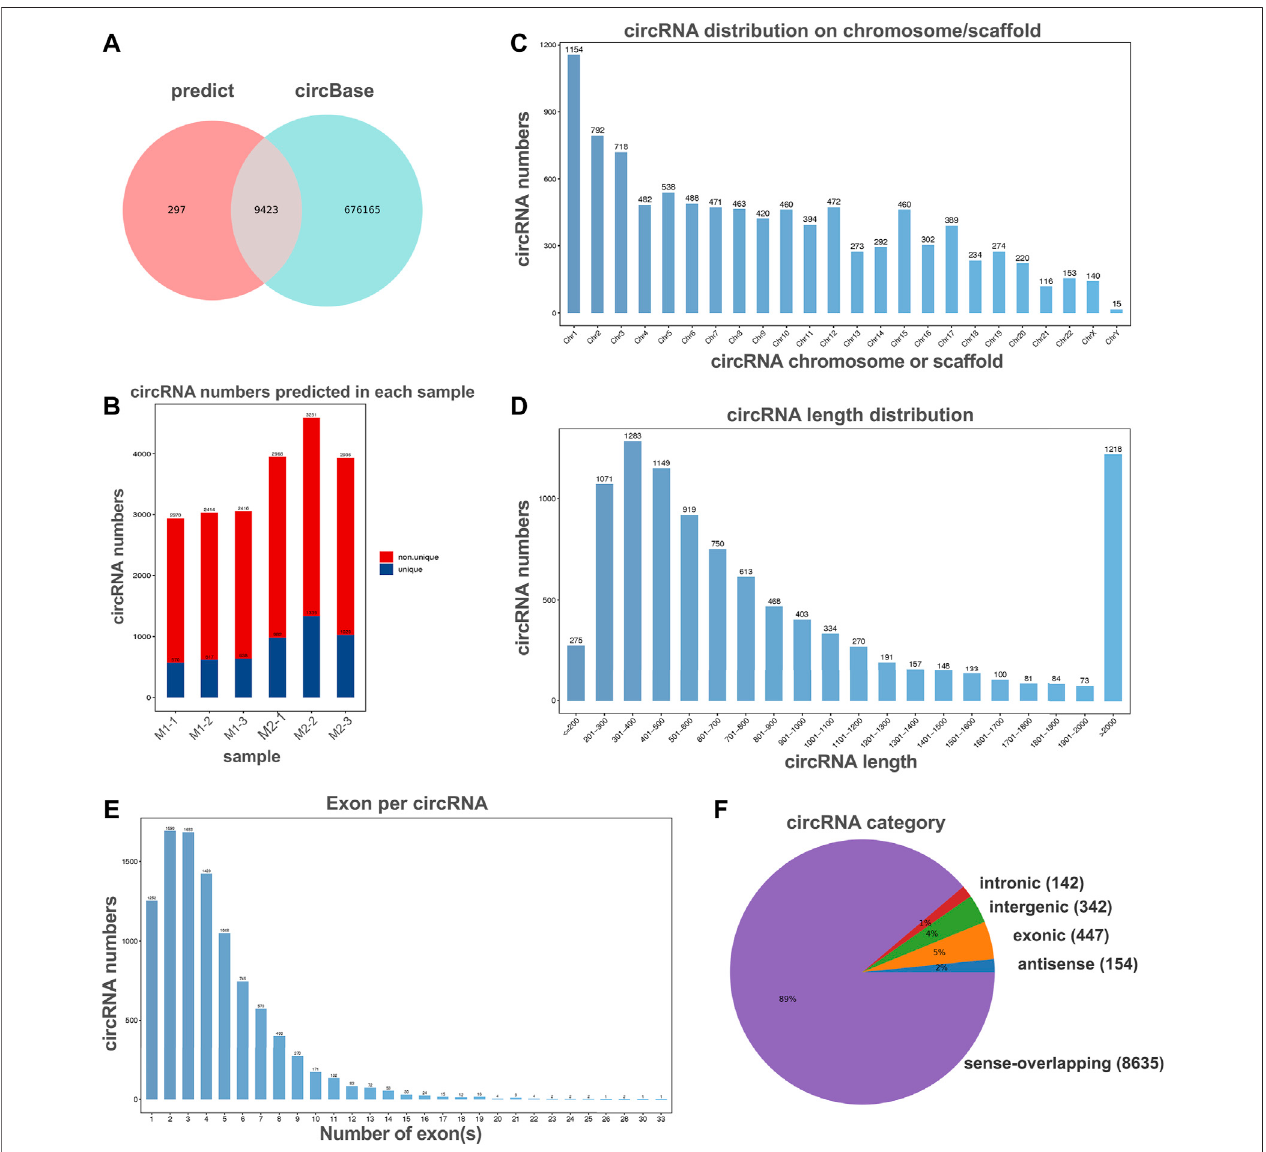
FIGURE2| Overview ofcircRNA pro fi les ofpolaroized macrophages. (A) Venn analysisfor comparison ofpredictedcircRNAs withthedata published in circBase. (B) The number of predicted circRNAs in M1 macrophages (M1-1, M1-2, M1-3) and M2 macrophages (M2-1, M2-2, M2-3). (C) Chromosome/scaffold distribution of predicted circRNAs. (D) Length distributionofpredictedcircRNAs. (E) Theexonnumbers distribution ofpredicted circRNAs. (F) Categoryofpredicted circRNAs based on genomic origin.